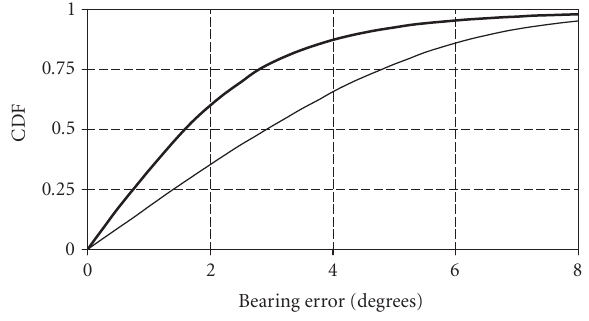
Figure 8: The CDFs of the bearing estimation error for various SNRs. The number of scatterers is N = 12 (solid curves) and N = 3 (dashed curves).